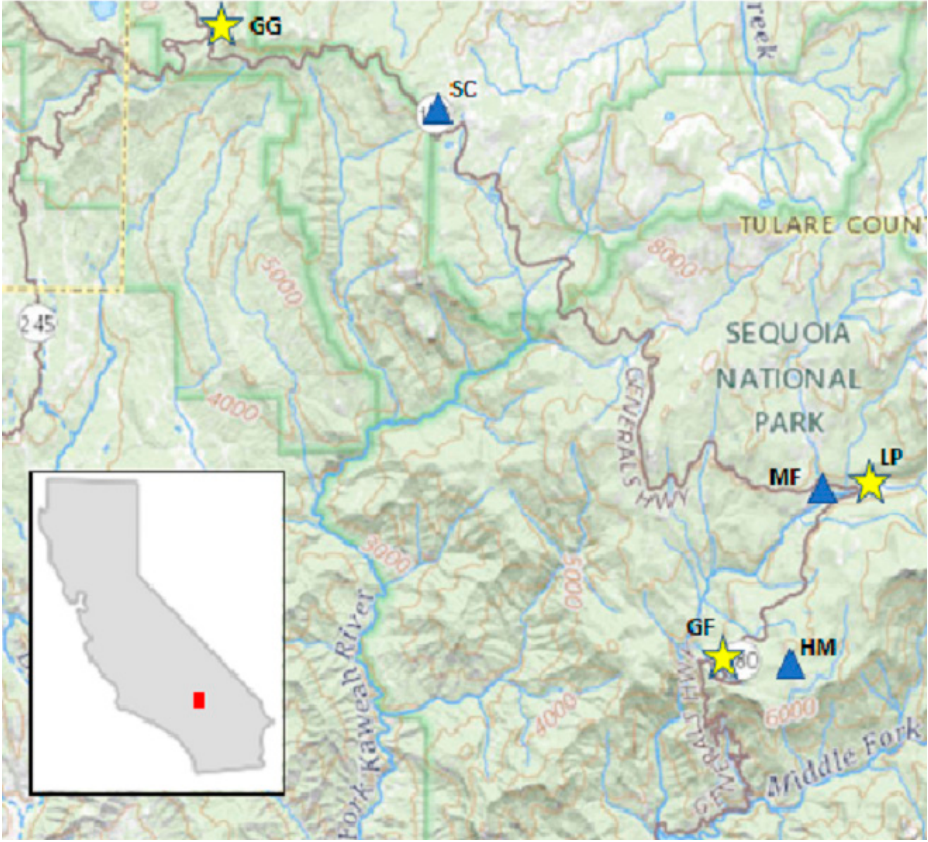
Figure 1. Location of study sites (triangles) and meteorological stations (stars) in Sequoia National Park (Marble Fork, MF; Huckleberry Meadow, HM) and Monument (Stoney Creek, SC).